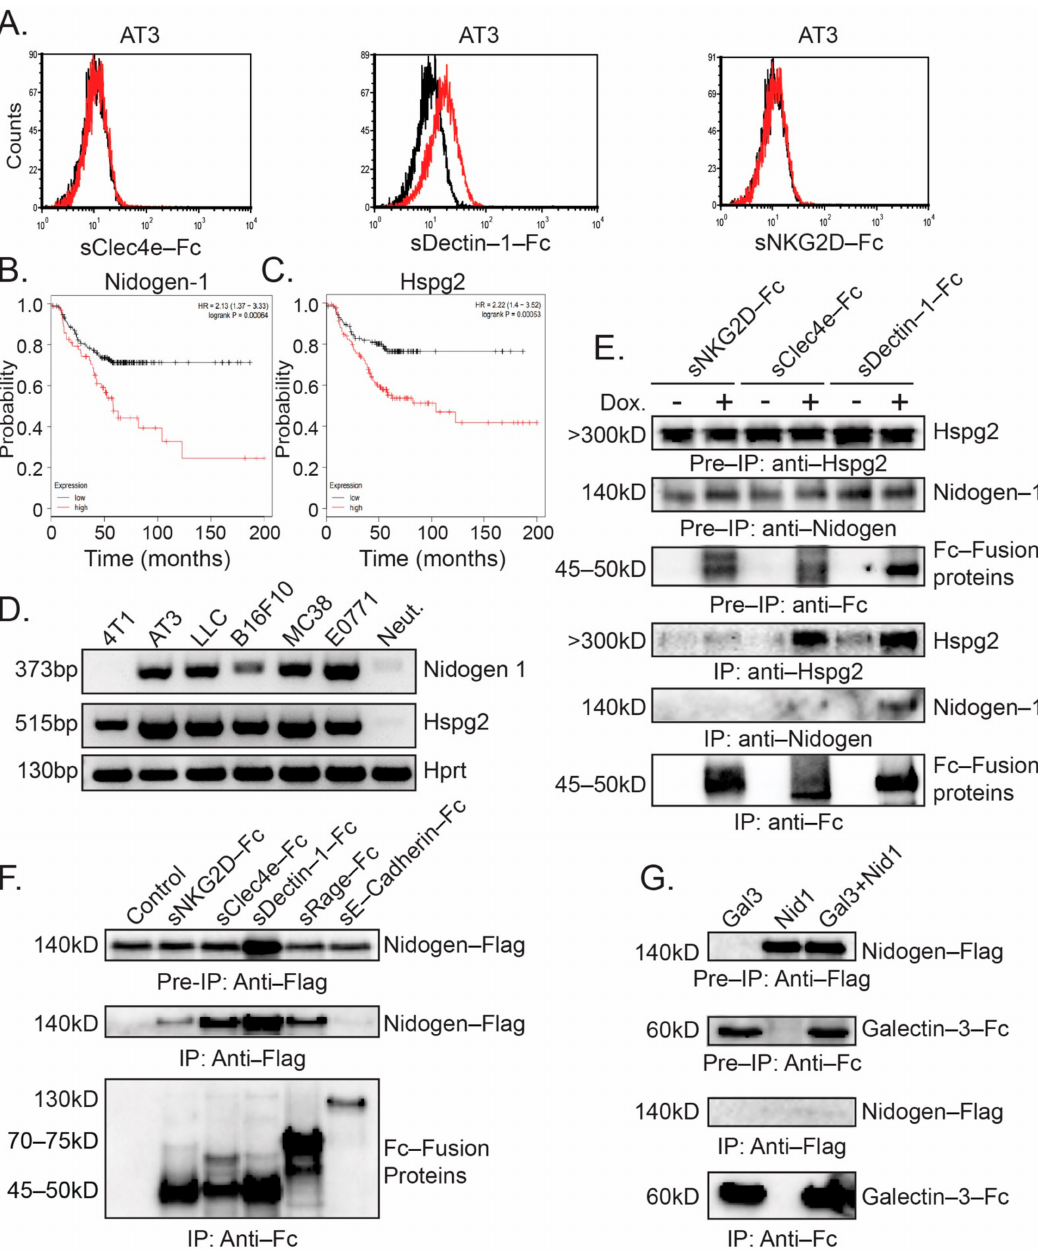
Figure 4. ( A ) Binding of sDectin-Fc to the cell surface of AT3 cells. AT3 cells were incubated with supernatant containing sClec4e-Fc, sDectin-1-Fc or sNKG2D-Fc, followed by incubation with APC- anti-Fc antibodies (red histograms). Black histograms represent 2nd antibody alone. ( B ) Kaplan-Meier Plot of survival of Her-2 positive breast cancer patients with low (black) or high (red) expression of Nidogen-1. ( C ) Kaplan-Meier Plot of survival of Her-2 positive breast cancer patients with low (black) or high (red) expression of Hspg2. ( D ) RT-PCR analysis of Nidogen-1 and Hspg2 expression in various tumor cell lines and in neutrophils (Neut.). ( E ) Co-immunoprecipitation of endogenous Nidogen-1 and endogenous Hspg2 in AT3 cells overexpressing tet-inducible Fc fusion proteins as indicated. Induction of Fc fusion proteins was done by adding 1 µ g/mL doxycycline (Dox.) to the culture. Pre-IP = Cell extract samples prior to immunoprecipitation. IP = Immunoprecipitated samples. ( F ) Immunoprecipitation of Nidogen-1-Flag using the indicated Fc fusion proteins as baits. The proteins were overexpressed in AT3 cells. ( G ) Immunoprecipitation study of Nidogen-1-Flag using Galectin-3-Fc fusion protein as a bait. The proteins were overexpressed in AT3 cells. Pre-IP = Cell extract samples prior to immunoprecipitation. IP = Immunoprecipitated